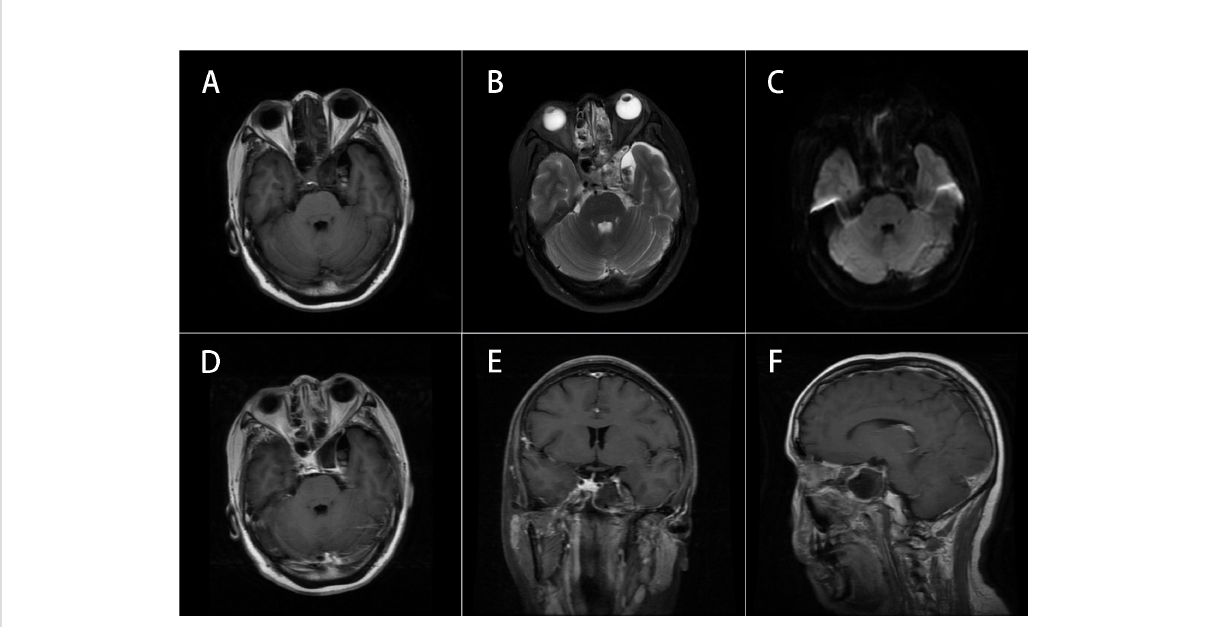
FIGURE 3 MRI of the brain with and without contrast. (A – C) Corresponded to Figure 1A – C and (D – F) corresponded to Figure 1E – G respectively. The lesion had been completely resected and the abnormal signals observed on the preoperative imaging had